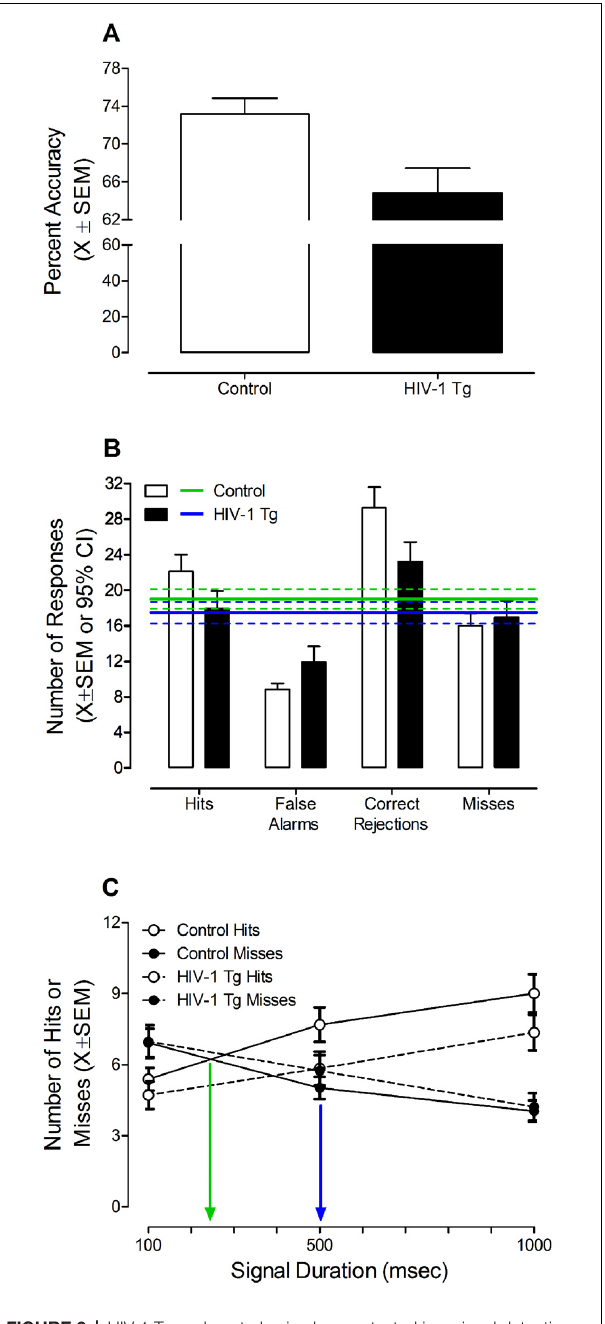
FIGURE 3 | HIV-1 Tg and control animals were tested in a signal detection operant task with varying signal durations prior to treatment with S-Equol. (A) HIV-1 animals exhibited a significantly lower percent accuracy relative to control animals ( p ≤ 0.05). (B) Control animals exhibited a significantly greater number of hits and correct rejections, in combination with a significantly fewer number of false alarms and misses, supporting learning all of the task contingencies. HIV-1 Tg animals, however, only exhibited an increased number of correct rejections and a decreased number of false alarms. (C) The assessment of sustained attention revealed that HIV-1 Tg animals exhibited a prominent rightward shift in the loss of signal detection (i.e., the intersection of hits and misses; p ≤ 0.05) relative to control animals. Data are presented as mean ±